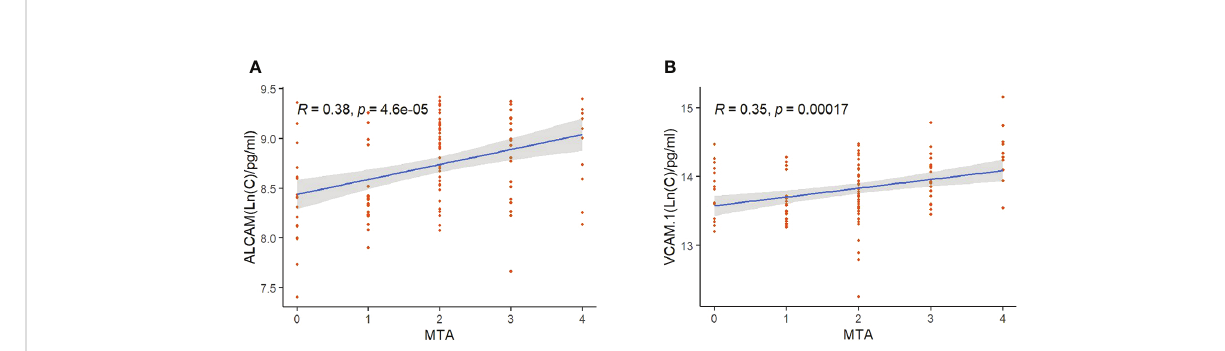
FIGURE 3 The correlation between ALCAM, VCAM-1, and MTA in all participants: (A) Spearmen correlation analysis revealed a signi fi cant correlation of ALCAM with MTA (r=0.38, p<0.001). (B) Spearmen correlation analysis revealed a signi fi cant correlation of VCAM-1 with MTA (r=0.35, p<0.001). * The blue line represents the fi tting line. Shadows represent a 95% con fi dence